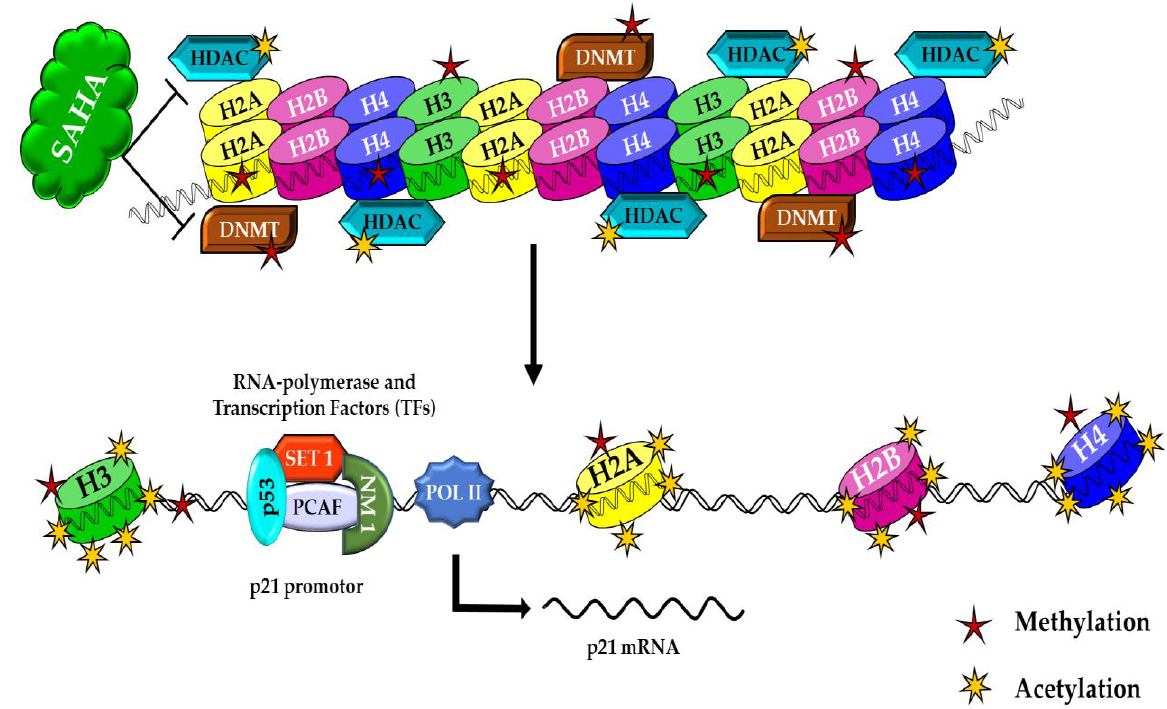
Figure 9. In HDAC inhibitor-treated cancer cells, SAHA helps to augment acetylation, which leads to increased acetylation and decreased methylation of histones. These histone modifications induce higher levels of p21 WAF1/CIP1 expression in A2780 cancer cells. Upon further stimulation (ex: hyperacetylation), activation of p21 WAF1/CIP1 gene transcription results in a prolonged retention of cancer cells’ epigenetic alterations.